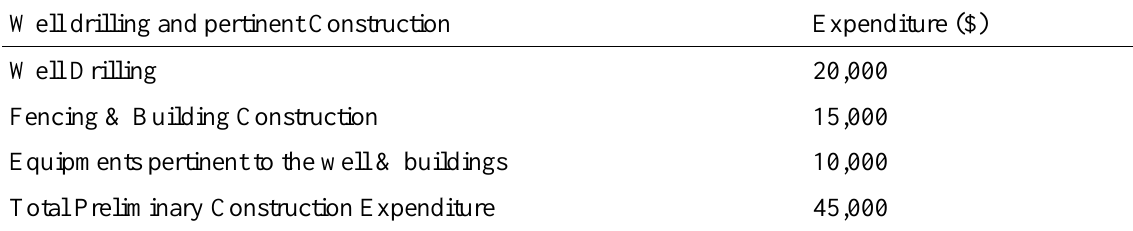
Table 1. Well drilling, fencing, and construction expenditure in Iran Well drilling and pertinent